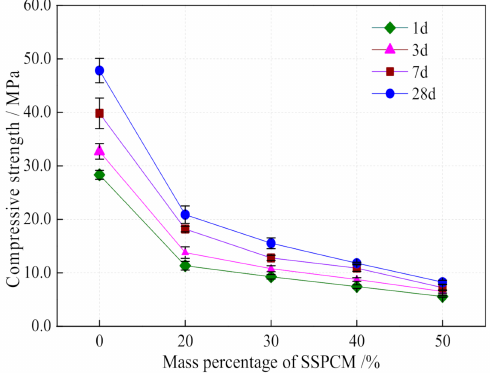
Figure 16. Compressive strength of